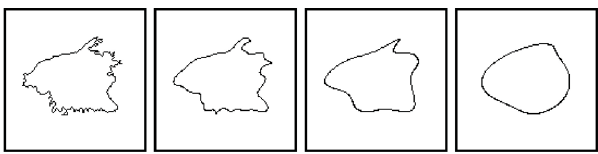
Fig. 5 Left to right: original contour, and reconstructed contours using L = 37, 17, and 7 Fourier coefficients.